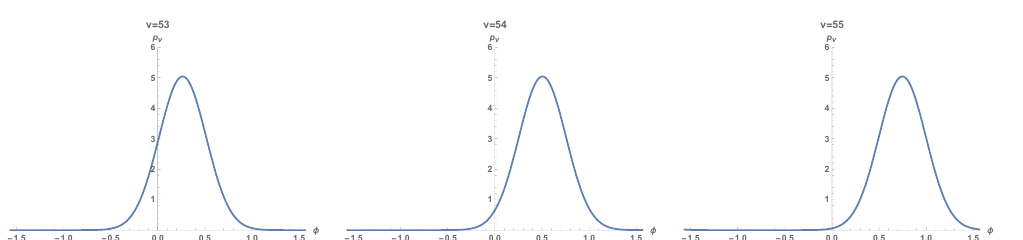
Figure 7 . Dynamical evolution of a perturbed Einstein black ring near y = (cid:0) 1 =R , with m = 2 and m=R = 0 : 5.